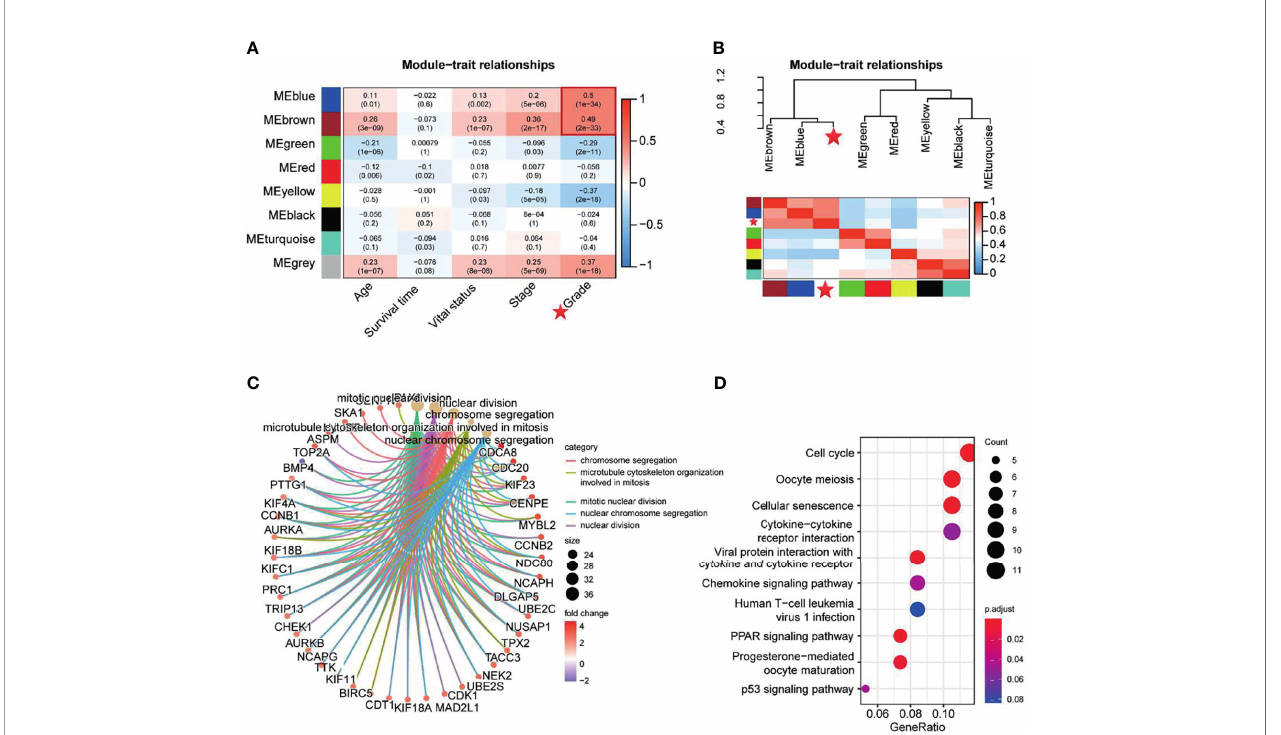
FIGURE 4 | Identi fi cation of key modules related to the clinical traits. (A) Module − trait heatmap of the correlation between module eigengenes and 5 clinical traits of UCEC. The P -values of each module ’ s correlation with the corresponding clinical trait were shown in parentheses. (B) Hierarchical clustering dendrogram of MEs and neoplasm histologic grade (labeled by asterisk). Heatmap of the adjacencies in the eigengene network, including neoplasm histologic grade. (C, D) GO term enrichment and KEGG pathway analysis for DEGs in the Blue and Brown